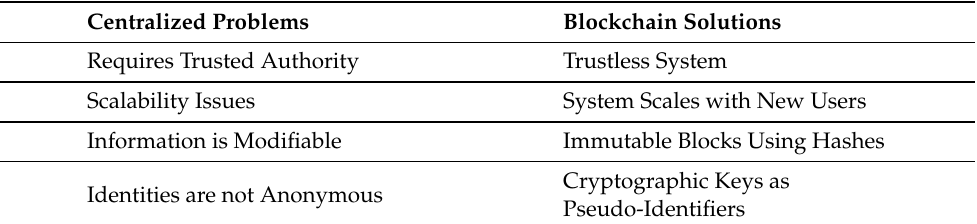
Table 1. Blockchain solutions for centralized system